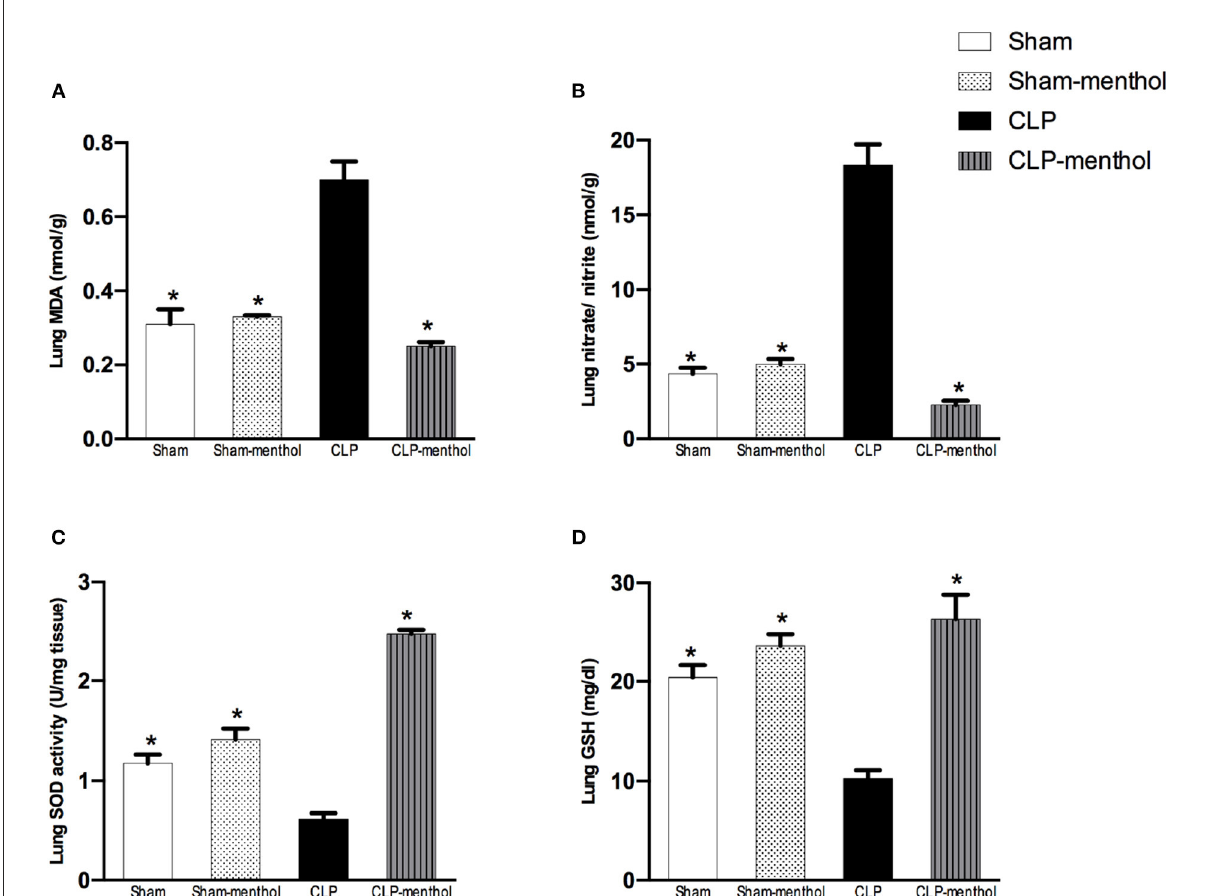
FIGURE4 Menthol treatment improves pulmonary oxidative stress status and inhibits the sepsis-induced reduction of the antioxidant capacity of lung tissue. Menthol treatment of CLP rats ameliorated CLP-induced oxidative imbalance in lung tissues as shown with the results of (A) , malondialdehyde (MDA), (B) nitrate/nitrite, (C) activity of superoxide dismutase (SOD) and (D) , reduced glutathione (GSH). Menthol (100 mg/kg, p.o), 2h after surgery. n = 6 per group. Data were analyzed by one-way ANOVA followed by Tukey’s post-test for multiple comparison. Data represent the mean ± SEM of 6 independent observations. * Significantly different from the CLP group at p <